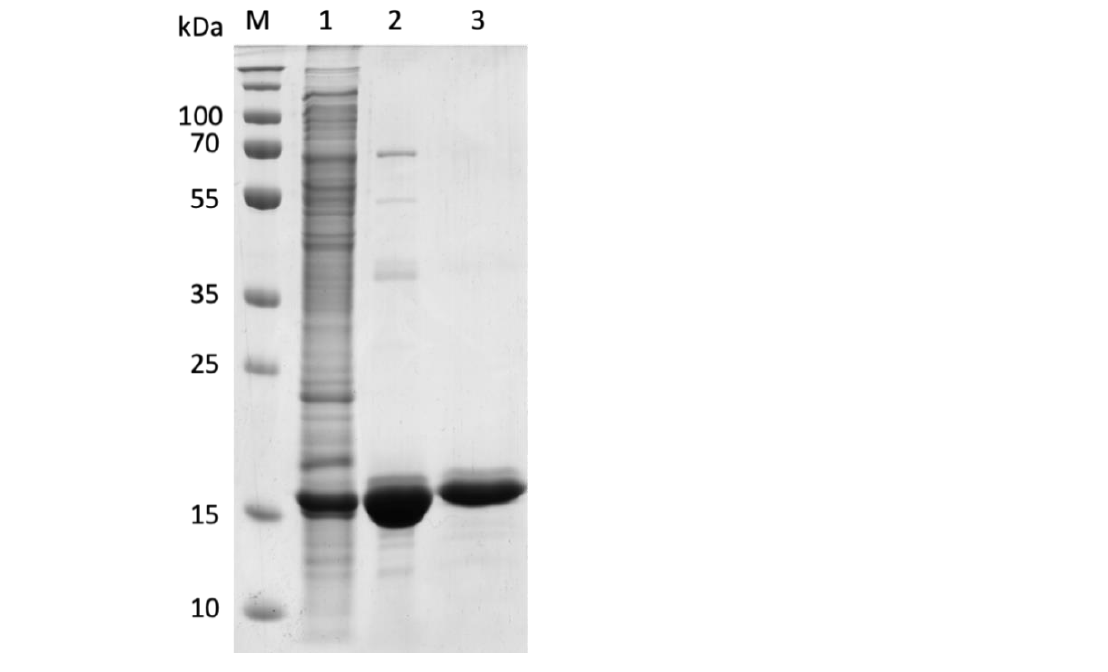
Figure 4. Homologous overexpression and purification of Lrp in Hfx. mediterranei HM26- Δ lrp . Proteins are shown on a 14.0% SDS-PAGE after Coomassie Brilliant Blue staining. M: PageRuler Plus Prestained Protein Ladder (Thermo Fisher Scientific, Waltham, MA, USA); Line 1: Overexpression of Lrp; Line 2: His-tagged fraction; Line 3: Superose6 Increase 10/300 GL fraction. Table 3. Description of the purification steps for Lrp from Hfx. mediterranei